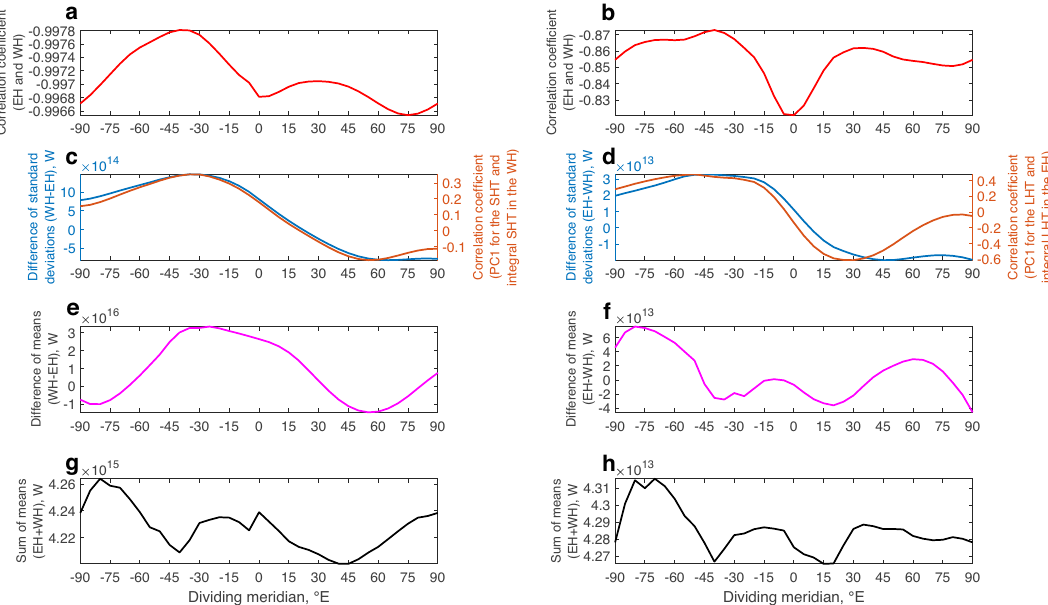
Figure 5. Sensitivity experiments for the dipole pattern in the integral sensible (SHT (W), left) and latent (LHT (W), right) heat transports in the entire troposphere (1000–100 hPa) for the Eastern and Western Hemispheres (EH and WH). ( a ) Anti-phase pattern between the EH and WH for the SHT. ( b ) Anti-phase pattern between the EH and WH for the LHT. ( c ) Difference of standard deviations for the SHT (WH – EH) along with the correlation coefficients between the first principal component time series (PC1) for the SHT and integral SHT in the WH. ( d ) Difference of standard deviations for the LHT (EH – WH) along with the correlation coefficients between the first principal component time series (PC1) for the LHT and integral LHT in the EH. ( e ) Difference of means (WH − EH) for the SHT. ( f ) Difference of means (EH – WH) for the LHT. ( g ) Sum of means (EH + WH) for the SHT. ( h ) Sum of means (EH + WH) for the LHT. The Matrix Laboratory (MATLAB) with version R2017b (https:// www. mathw orks. com/) was used to generate this